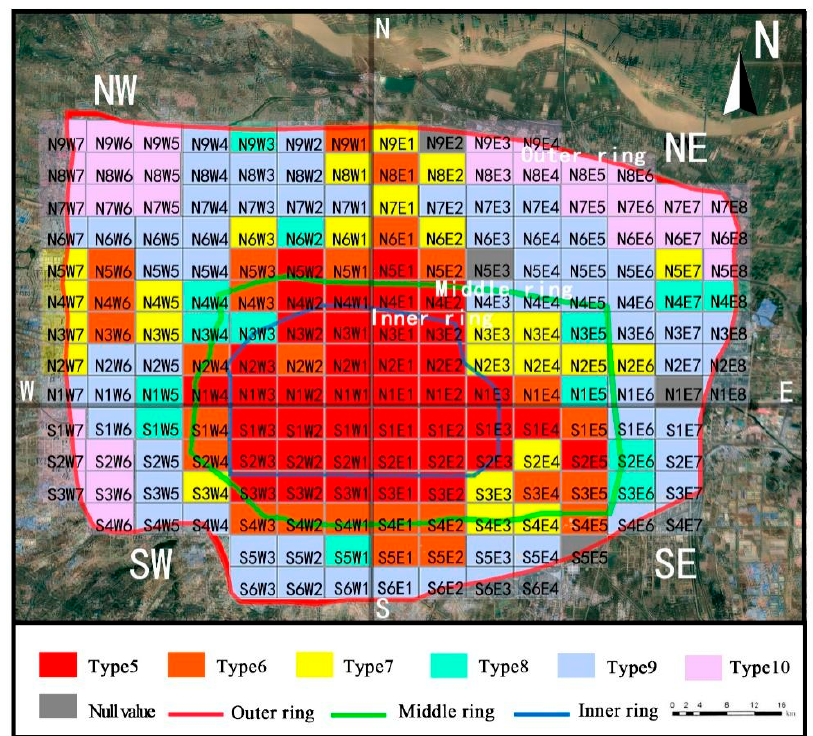
Figure 7. 3D spatial form distribution of buildings in Zhengzhou outer ring.